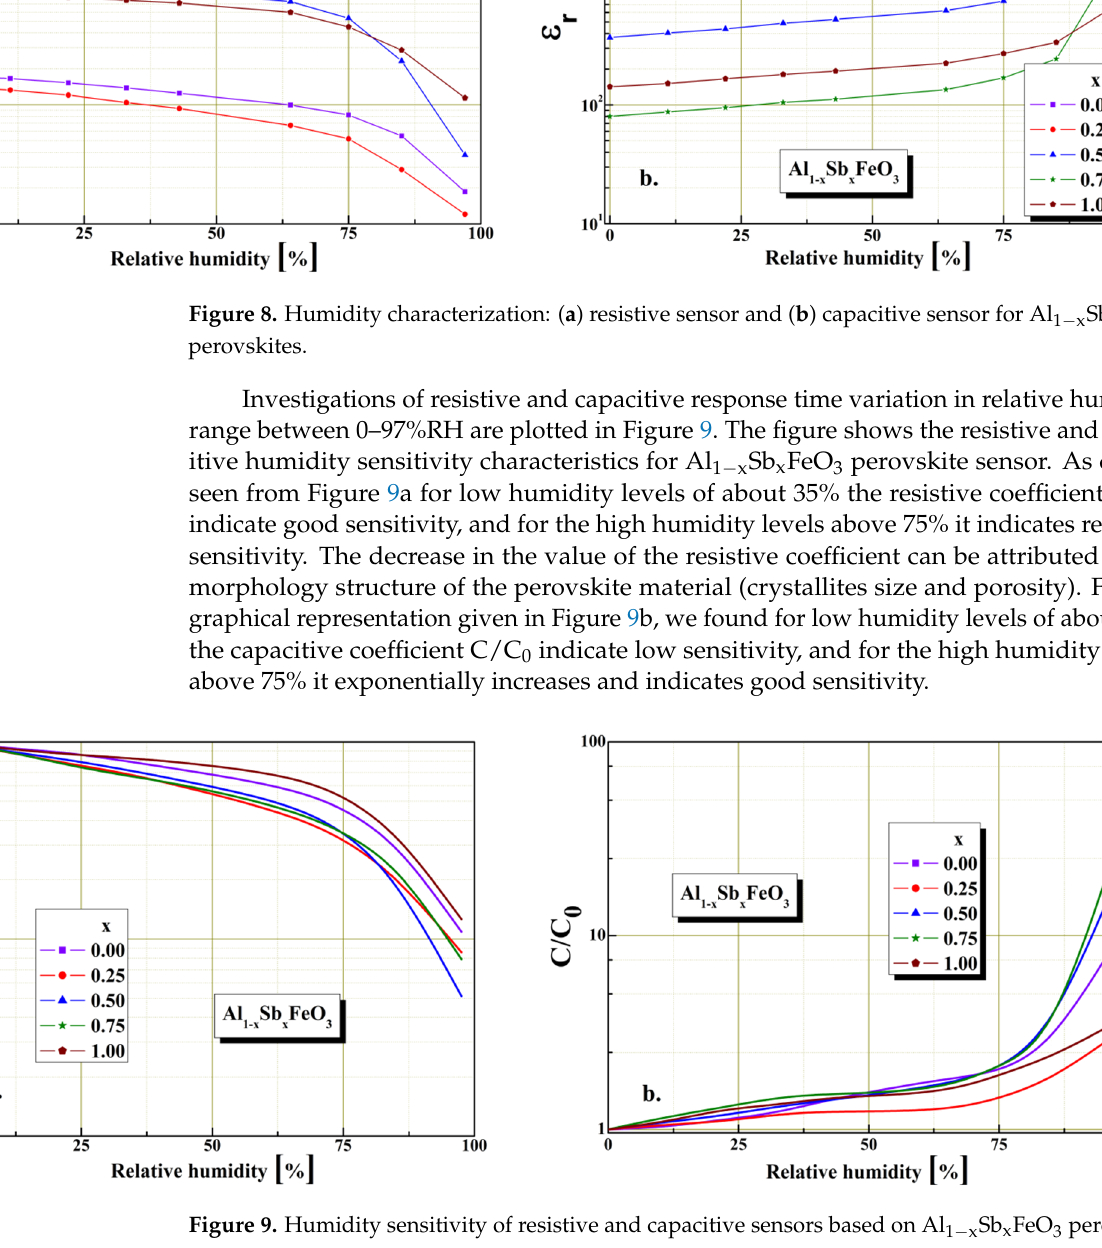
Figure 9. Humidity sensitivity of resistive and capacitive sensors based on Al 1-x Sb x FeO 3 perovskite material: ( a ) electrical resistance in normalized form ( b ) electrical capacitance in normalized form.